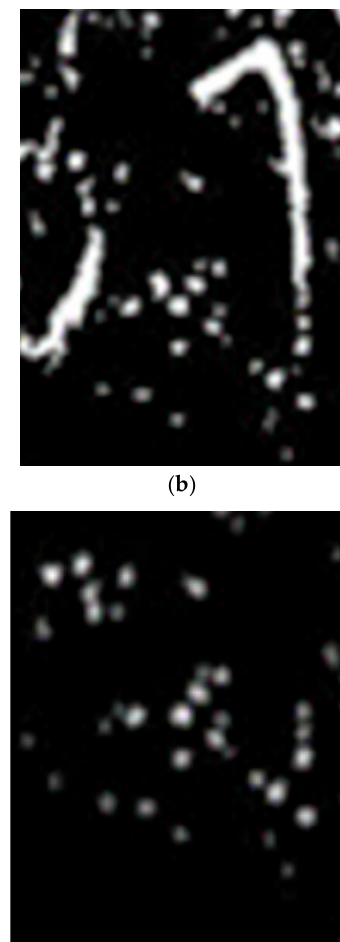
( b ) Figure 4. Shows a 3D view of the mouse calf, in ( a ), 3D visualization of the mouse calf, the rectan- gular shape is zoomed and presented in ( b ). Red arrows pointing to the blue ball-shaped particles representing clusters of IO-NPs. Figure 5a shows a slice of the 3D image of the mouse calf; Figure 5b shows the binary